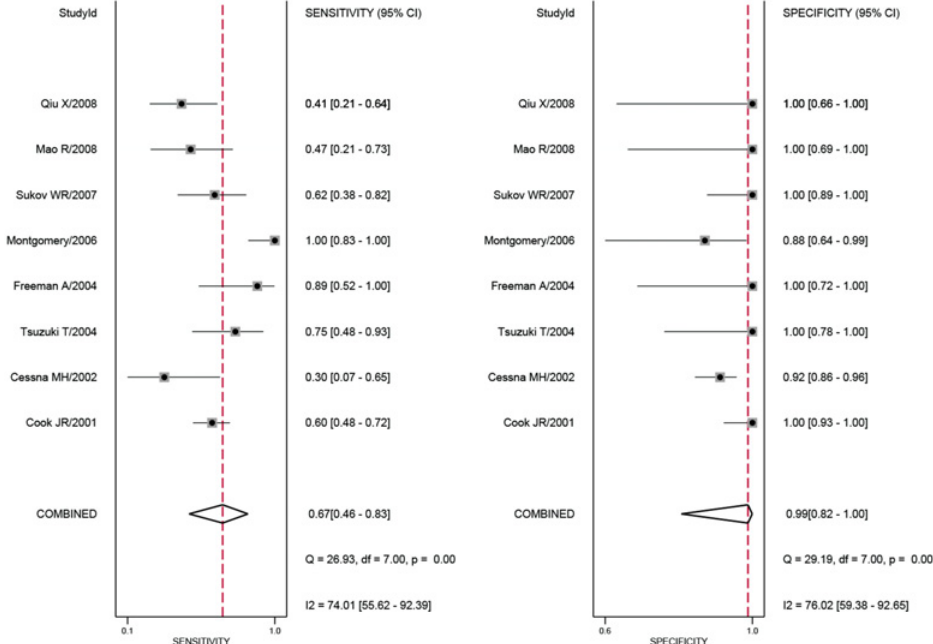
Fig 3. The overall forest plots of the estimates of sensitivity and specificity.